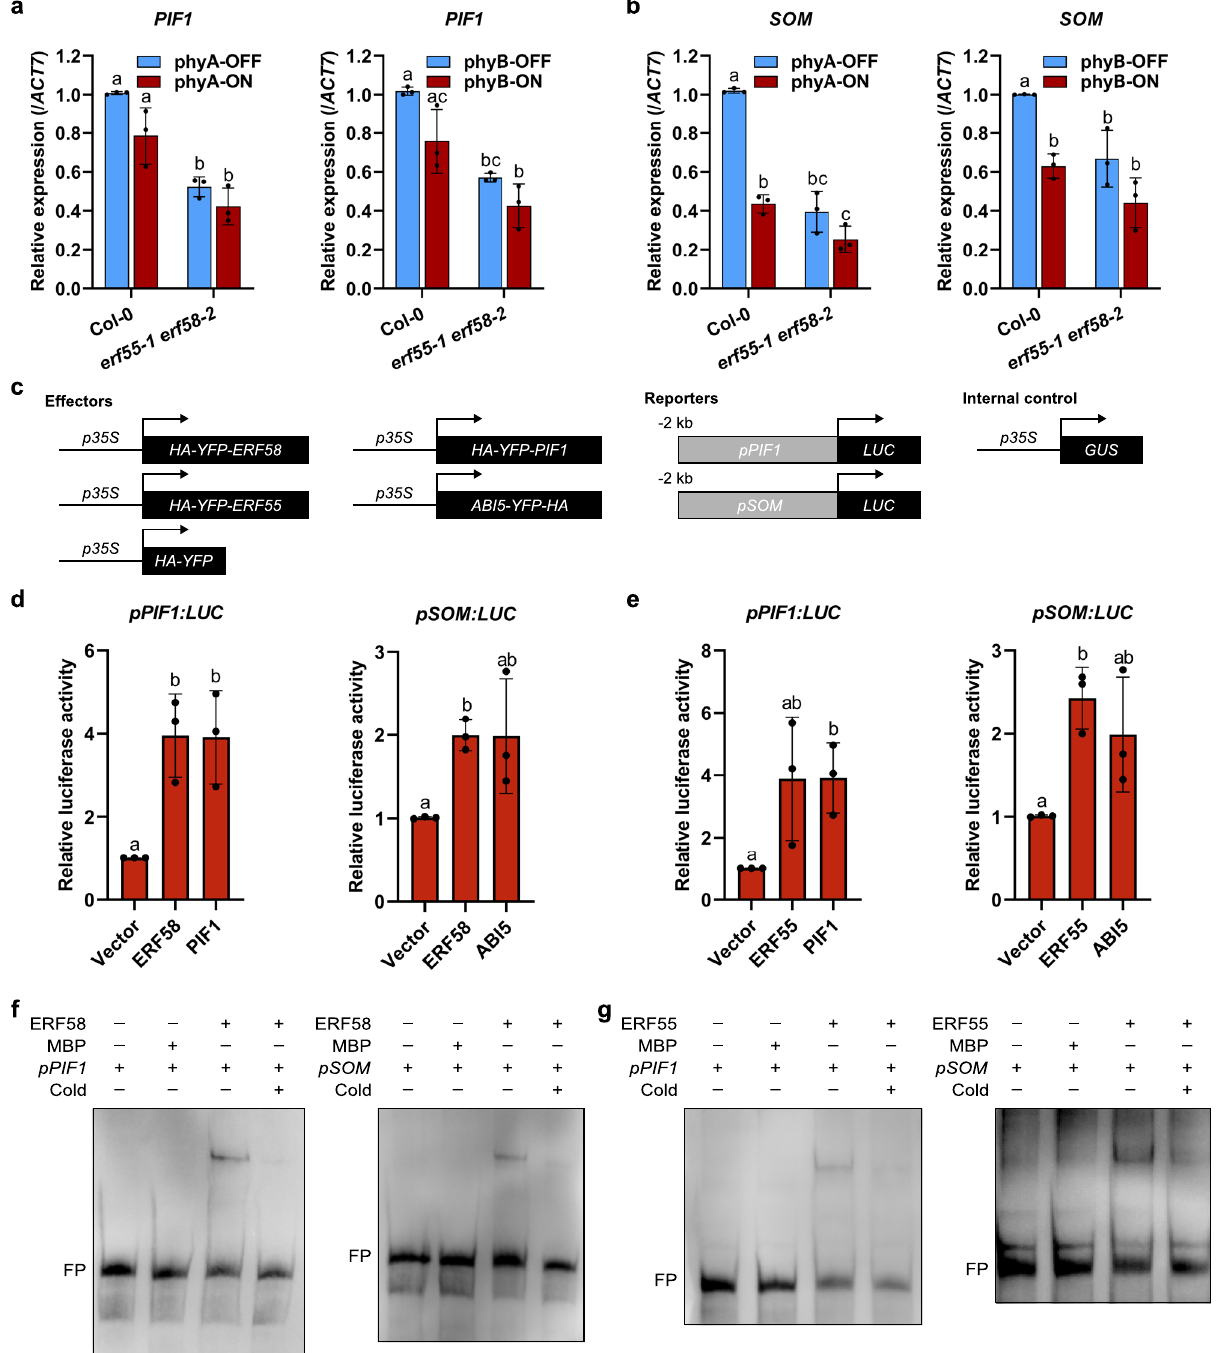
Fig. 3 ERF58 directly binds to the promoter of PIF1 and SOM to induce their expression. a , b RT-qPCR analysis of PIF1 ( a ) and SOM ( b ) expression in Col-0 and erf55-1 erf58-2 seeds germinating under phyA-ON/OFF or phyB-ON/OFF conditions. Light conditions are described in Supplementary Fig. 6a, b. ACT7 was used as an internal control. Values are means of three replicates ±SD. Different letters indicate signi fi cant differences as determined by two-way ANOVA followed by post-hoc Tukey ’ s HSD test; p < 0.05. c Constructs used for transactivation assays. d , e Transactivation assay in tobacco. Combinations of effector ( p35S:HA-YFP-ERF58 or p35S:HA-YFP-ERF55 ; p35S:HA-YFP was used as negative control; p35S:HA-YFP-PIF1 and p35S:ABI5-YFP-HA were used as positive controls) and reporter constructs ( pPIF1 − 1 … − 2000:LUC or pSOM − 1 … − 2000:LUC ) and p35S:GUS (used for normalisation) were transiently co-expressed in tobacco leaf epidermis cells by agro in fi ltration. LUC and GUS activity was measured in protein extracts from in fi ltrated leaves. Bars show mean relative LUC activity (LUC activity divided by GUS activity) of three replicates ±SD. Different letters indicate signi fi cant differences as determined by t -test and Holm – Bonferroni method; p < 0.05. f , g EMSAs. Biotin-labelled PIF1 and SOM promoter fragments ( pPIF1 − 801 … − 1031 and pSOM − 621 … − 840 ) were incubated with MBP-ERF58, MBP-ERF55, or MBP alone (negative control). Samples were analysed by native PAGE. Gels were blotted onto nylon membranes and signals were detected by streptavidin-coupled horseradish peroxidase and ECL. FP, free probe; Cold, excess of unlabelled DNA fragment containing the DRE motif to which ERF55/ERF58 bind. Experiments were repeated at least three times with similar